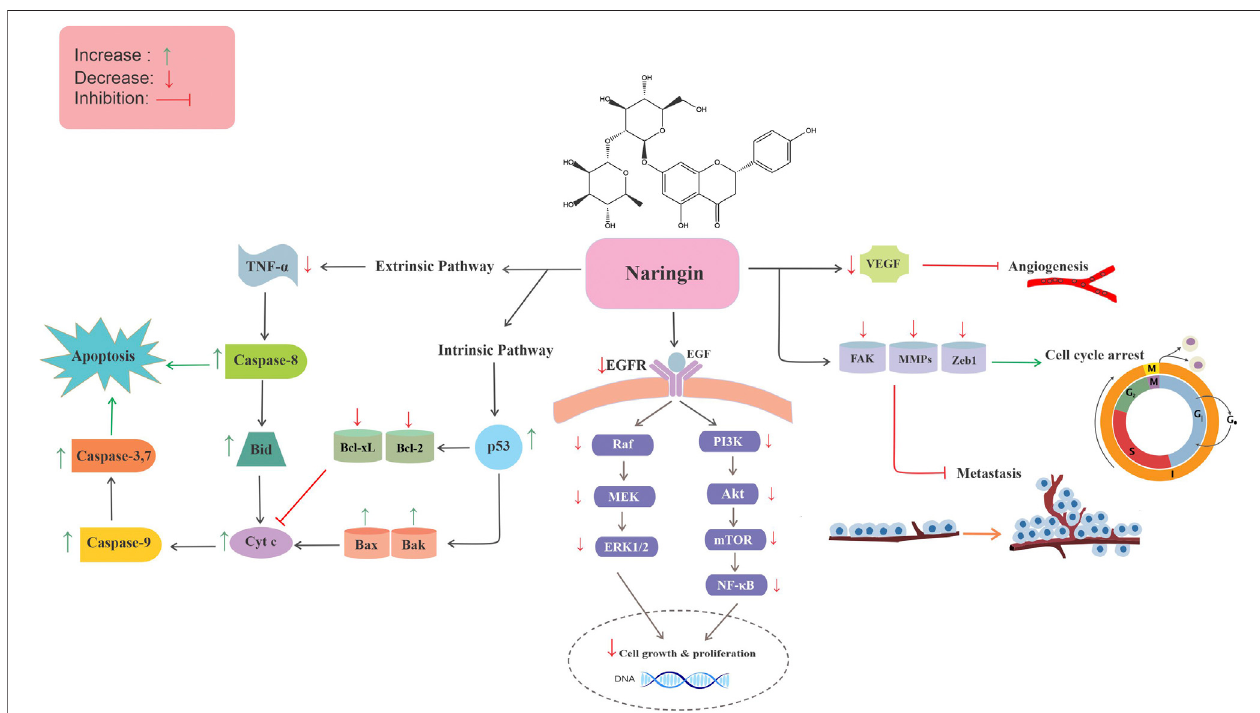
FIGURE3| Molecularmechanismsunderlyinganticancereffectofnaringin.Bax,Bcl-2-associatedXprotein;Bak,Bcl-2homologousantagonist/killer;Bcl-2,B-cell lymphoma 2; Bcl-xL, B-cell lymphoma-extra-large; Bid, BH3-interacting domain death agonist; cyt. c, cytochrome c; EGF, epidermal growth factor; EGFR, epidermal growth factor receptor; ERK1/2, extracellular signal-regulated kinase 1 and 2; FAK, focal adhesion kinase; MEK, mitogen-activated protein kinase; MMPs, matrix metallopeptidases; mTOR, mammalian target of rapamycin; NF- κ B, nuclear factor- κ B; p53, tumor protein p53; PI3K, phosphatidylinositol-3-kinase; Raf, rapidly accelerated fi brosarcoma; TNF- α , tumor necrosis factor- α ; VEGF, vascular endothelial growth factor; Zeb1, zinc fi nger E-box binding homeobox 1.